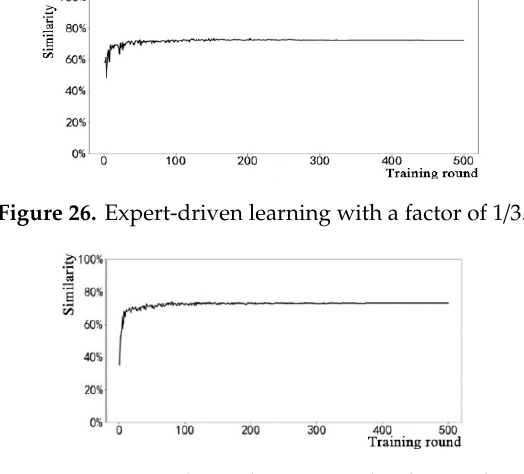
Figure 27. Expert-driven learning with a factor of 2/3.